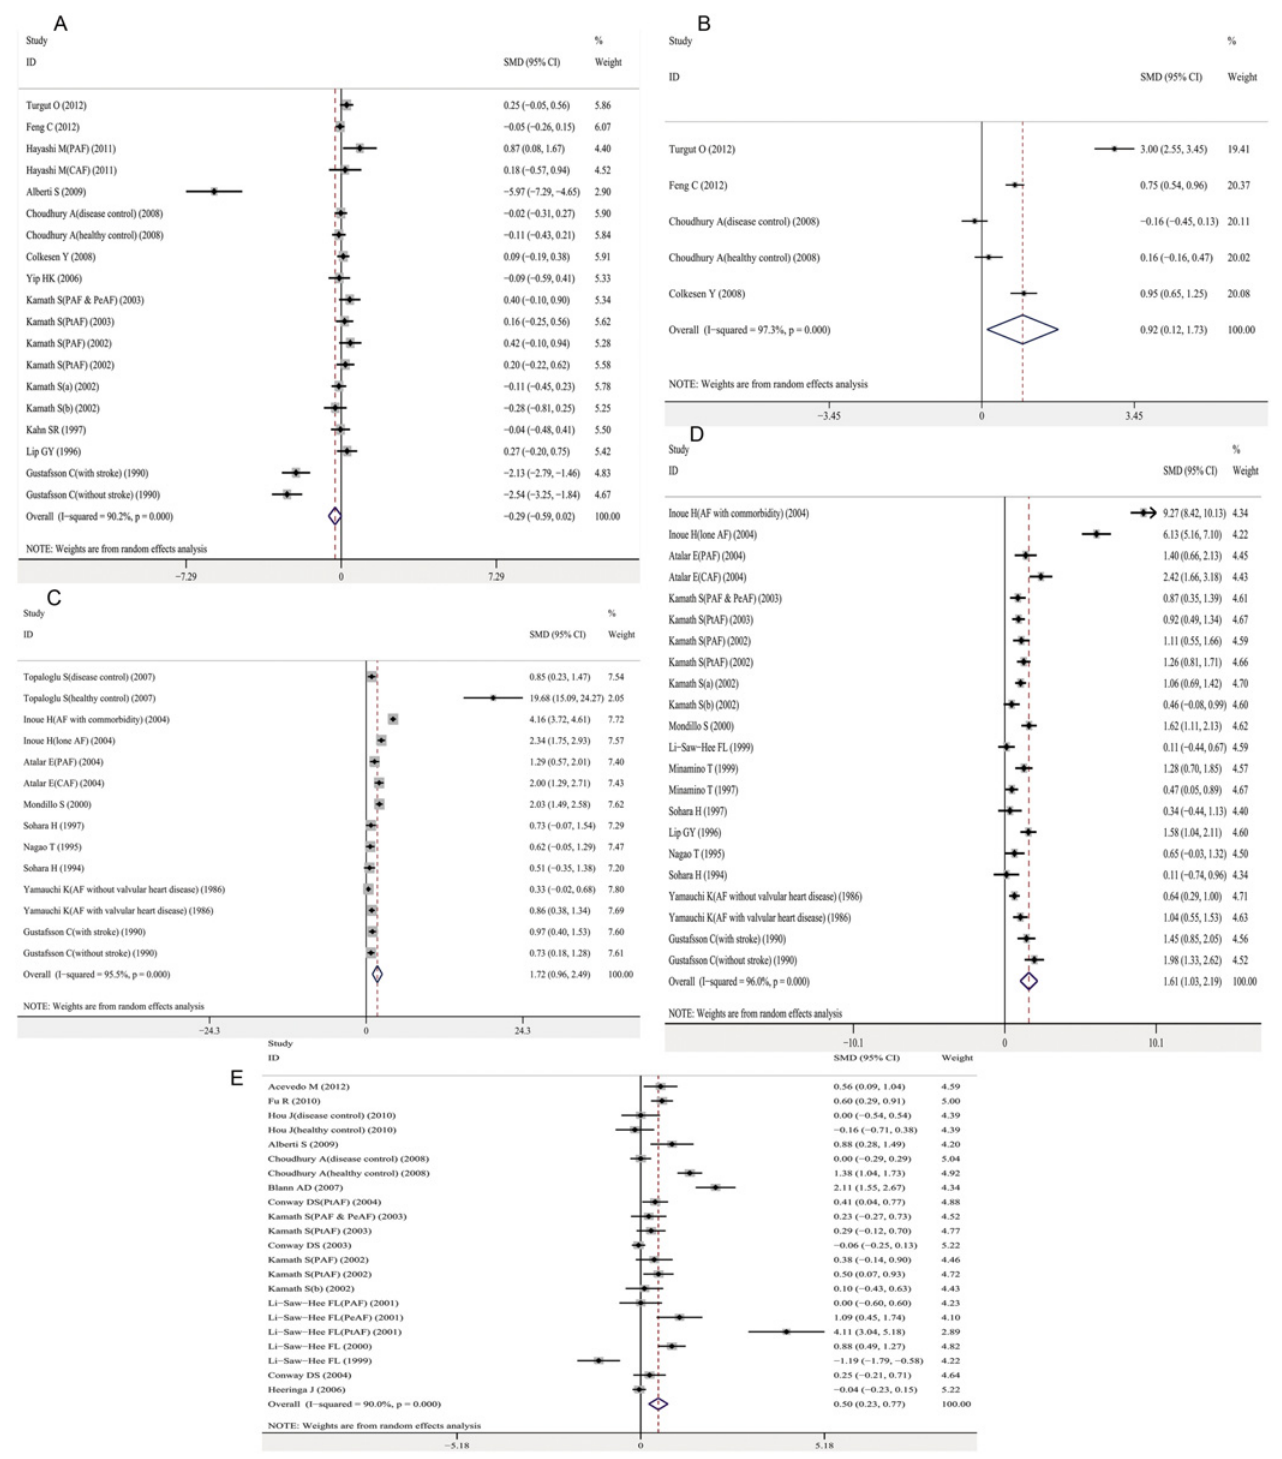
Fig 2. Association between platelet activation markers and AF. A. platelet count and AF; B. Mean platelet volume and AF; C. Platelet factor-4 and AF; D. β -thromboglobulin and AF; E. P-selectin and AF. Forest plots of SMD and overall SMD with 95% CI between AF cases and controls. Black diamonds indicate the SMD, with the size of the square inversely proportional to its variance, and horizontal lines represent the 95% CI. The pooled results are indicated by the black hollow diamond. AF, atrial fibrillation; MPV, mean platelet volume; PF-4, platelet factor-4; BTG, β -thromboglobulin; PAF, paroxysmal AF; PeAF, persistent AF; PtAF, permanent AF; CAF, chronic AF; SMD, standardized mean